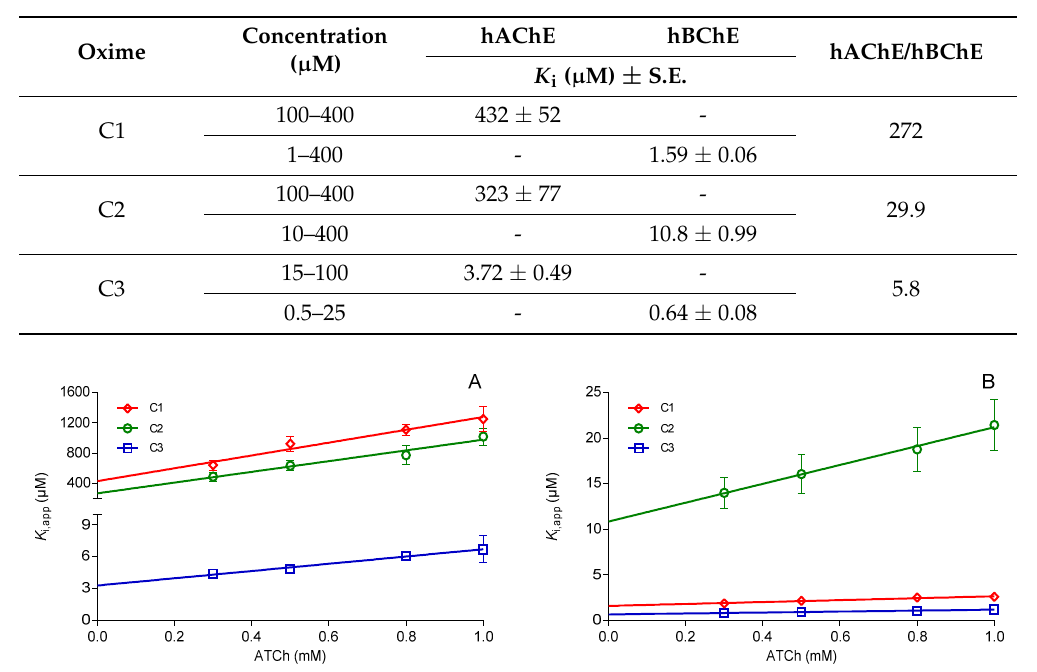
Figure 5. Reversible inhibition of ( A ) hAChE and ( B ) hBChE by the tested oximes. The graphs present Hunter-Downs plots with the average of the experimentally obtained values from at least three experiments. K i presenting the Y-intercept was studied in 0.3–1.0 mM substrate acetylthiocholine (ATCh) concentration range.